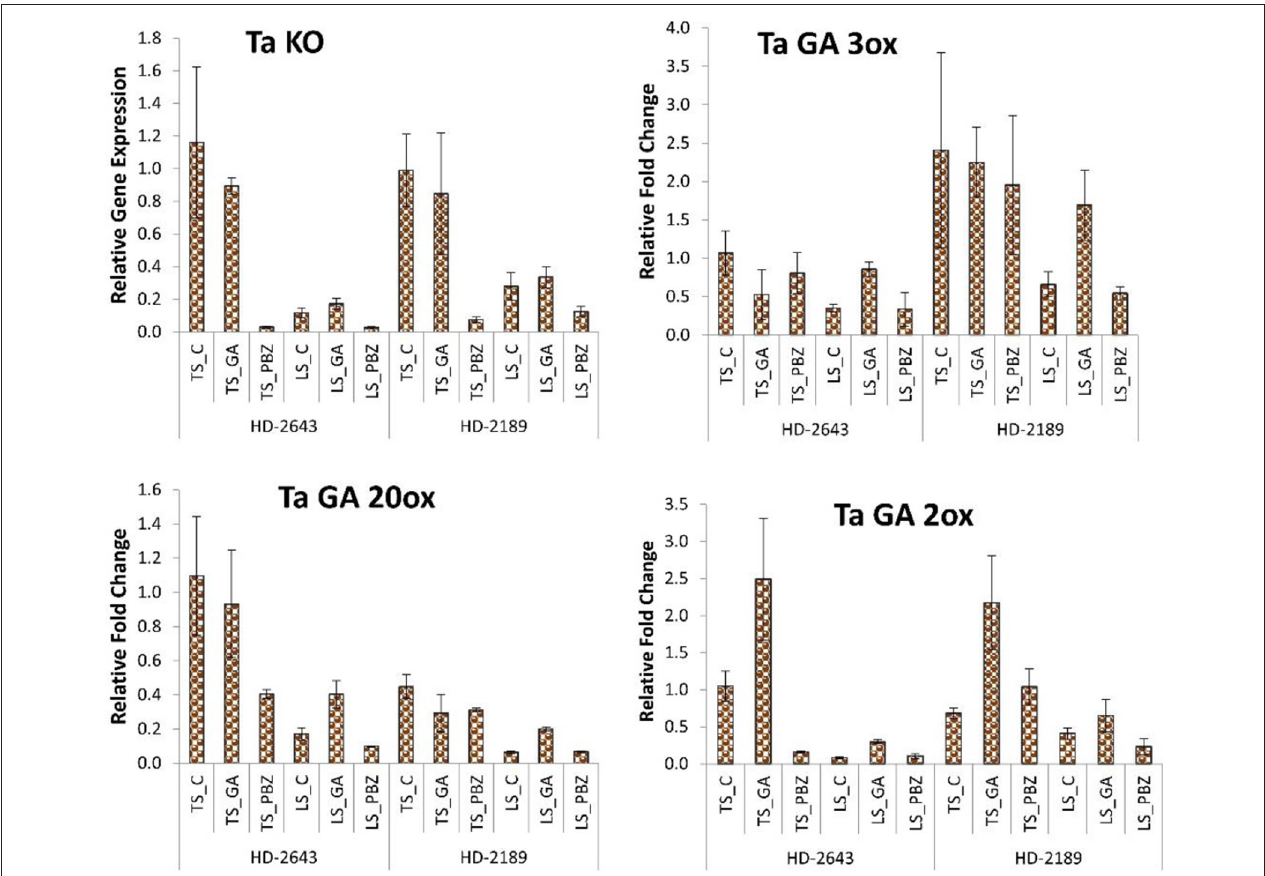
FIGURE 3 | Relative fold change in expression of GA biosynthesis and degradation genes, i.e., Kaurene oxidase (KO), GA 3oxidase, GA 20 oxidase, and GA 2 oxidase in developing grain. The error bar represents the standard error. Value on the ordinate is the mean of three replicates. On the abscissa, HD 2643 and HD 2189 are varieties; TS and LS denote timely sown and late sown of stress treatment, respectively; C, GA, and PBZ denote control, GA3, and paclobutrazol of spray treatment, respectively.